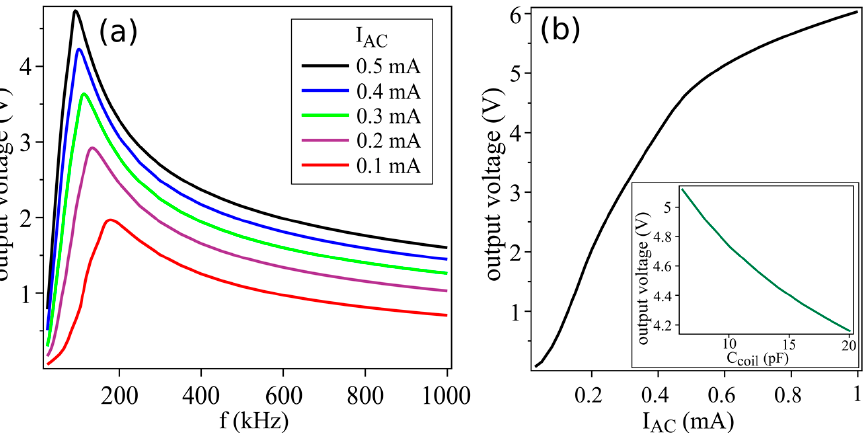
Figure 4. ( a ) Frequency response of PFVVS for inductance value of L = 10,000 μ H and different I AC ; ( b ) amplitude characteristic of the PFVVS for L = 10,000 μ H at f = 92.5 kHz; the inset shows PFVVS output voltage against coil parasitic capacitance.